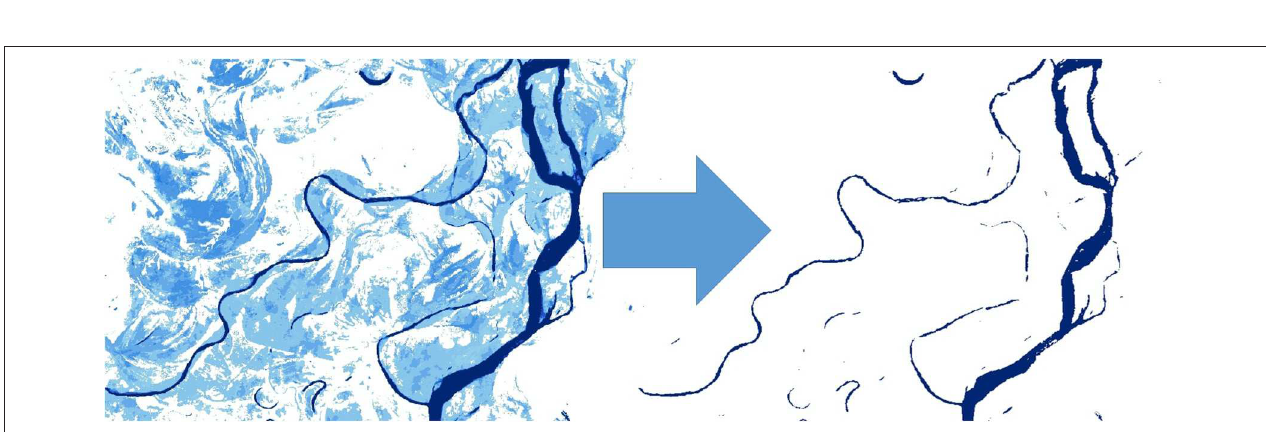
FIGURE 3 | The water occurrence map calculated from the JRC surface water data (left) and UNOSAT permanent water map data on the right.